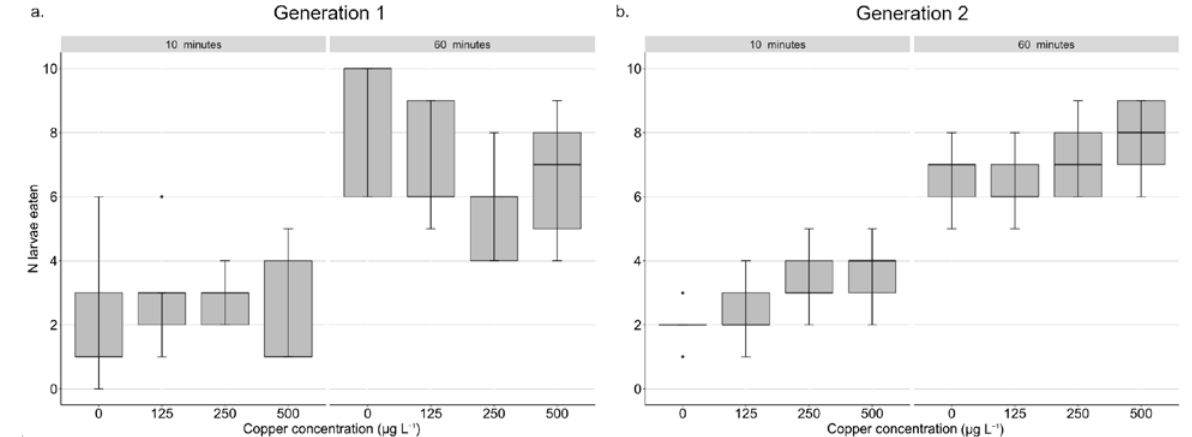
Figure 2. Effect of seven days of copper concentration exposures on the number of Culex pipiens